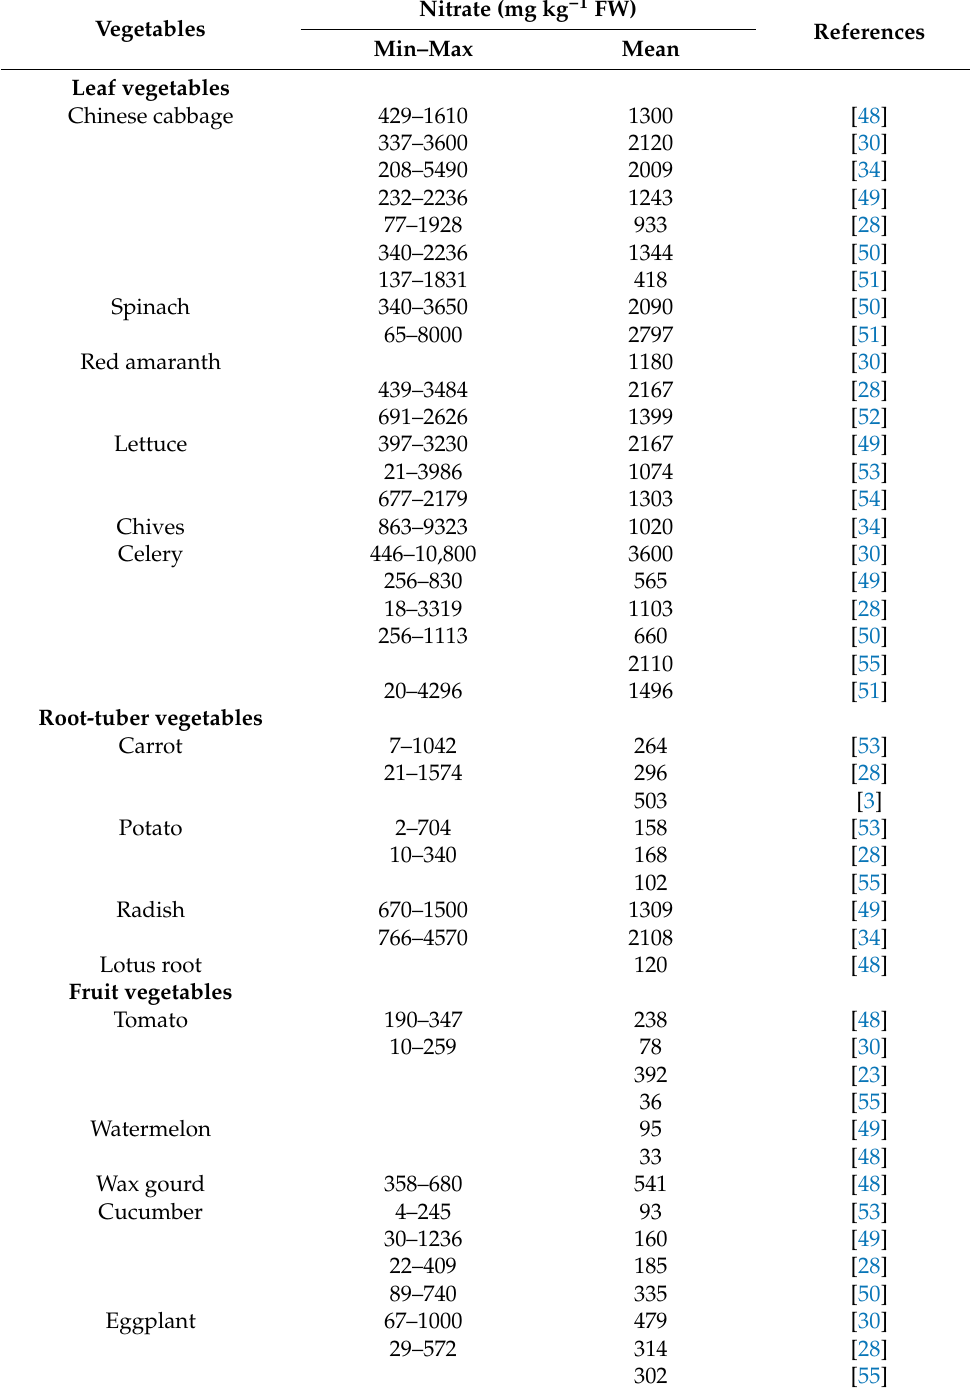
Table 8. Content of nitrate in fresh vegetables previously